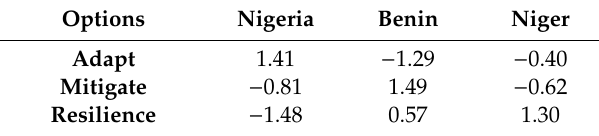
Table 13. Residuals for combined